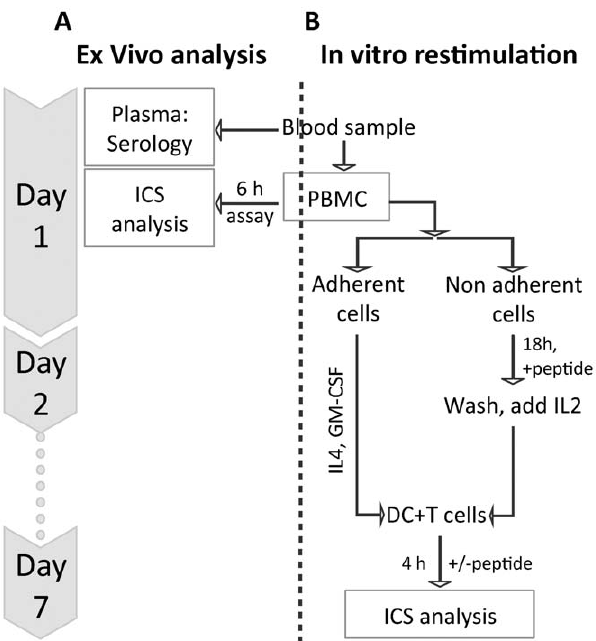
Figure 2. Flow diagram of the cell analysis. At day 1, some PBMC’s were use directly for an ex vivo analysis of pp65 specific T cells. The remaining PBMC’s were split in adherent and non-adherent cells. The non-adherent cells comprising the T cells were expanded on a pp65 peptide mixture. The peptide mixture was added overnight, washed away the next day, and the T cells were propagated on IL2 until day 7. At the same time, the adherent cells were cultured for 7 days in the presence of IL4 and GM-CSF to mature the into DC. At day 7, both the T cells and the DC’s were harvested. The DC’s were pulsed with the pp65 peptide mixture and added to the T cells (at the ratio 1:10) during a 4 h ICS assay.